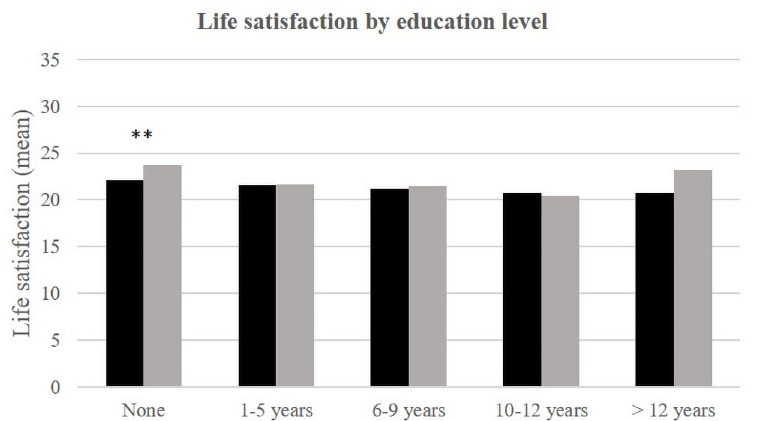
Fig 4. Life satisfaction (mean) by education level and place of life.